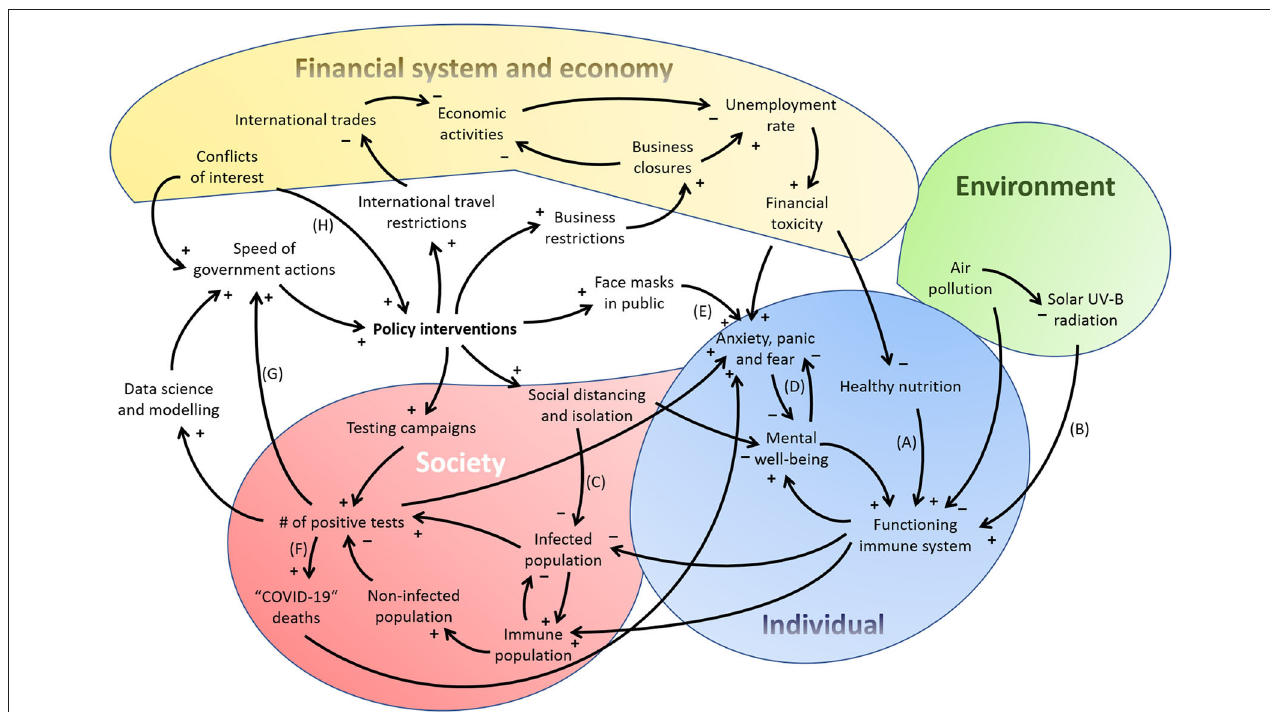
FIGURE 1 | A preliminary causal loop diagram displaying the complexity of the SARS-CoV-2 crisis’ environmental-individual-socio-economic-political system. Based on Figure 1 of Sahin et al. (11), but extended in some components and simplified in others not relevant for my main arguments